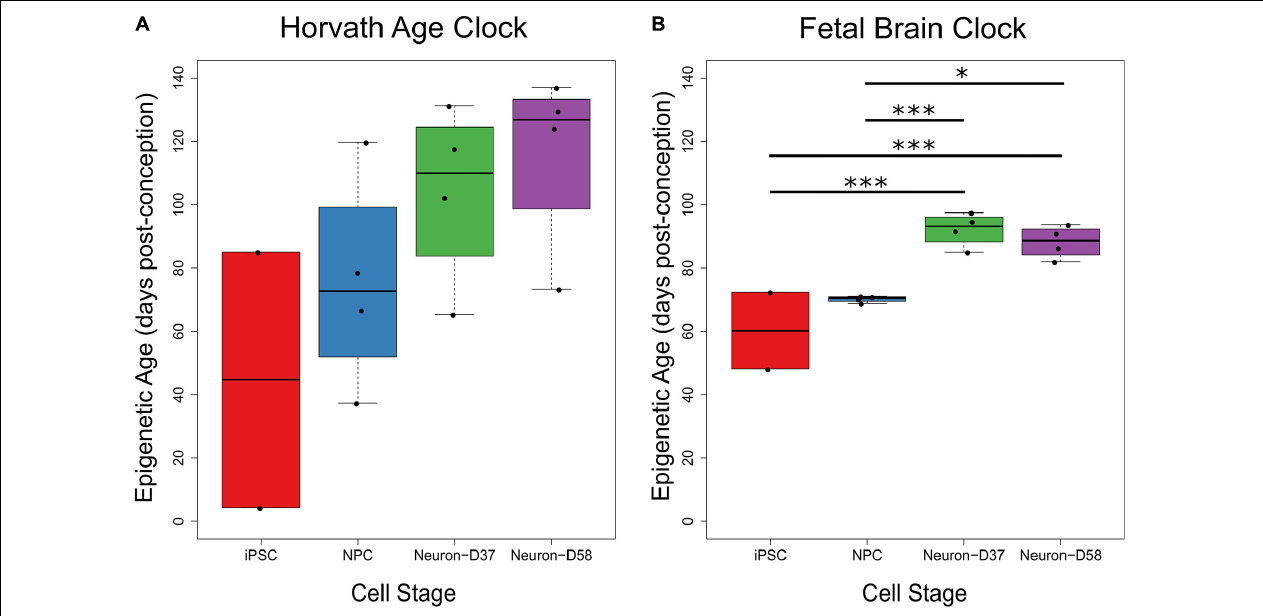
FIGURE 1 | The predicted biological ages of iPSC-derived neurons through differentiation using two different clocks. As two iPSC samples did not pass the quality control checks, there are only two samples in the iPSC group on each graph. (A) The estimated epigenetic age (Y-axis) of the four cellular stages (X-axis) increased throughout differentiation using the epigenetic age clock created by Horvath et al. (2018), although there were no significant differences between cellular stages. (B) The estimated epigenetic age of iPSCs and NPCs were significantly lower than the mature Days 37 and 58 neurons using the fetal brain epigenetic age clock created by Steg et al. (2020), but with no difference between iPSCs and NPCs or between Days 37 and 58 neurons. The age of each sample is given in days post-conception. Key: ∗ P < 0.05, ∗∗∗ P < 0.005.